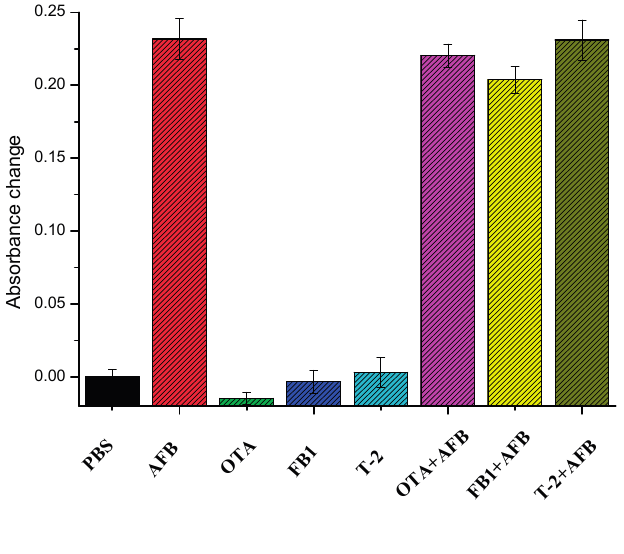
Figure 6. The selectivity of AFB determination using the developed immunoassay.